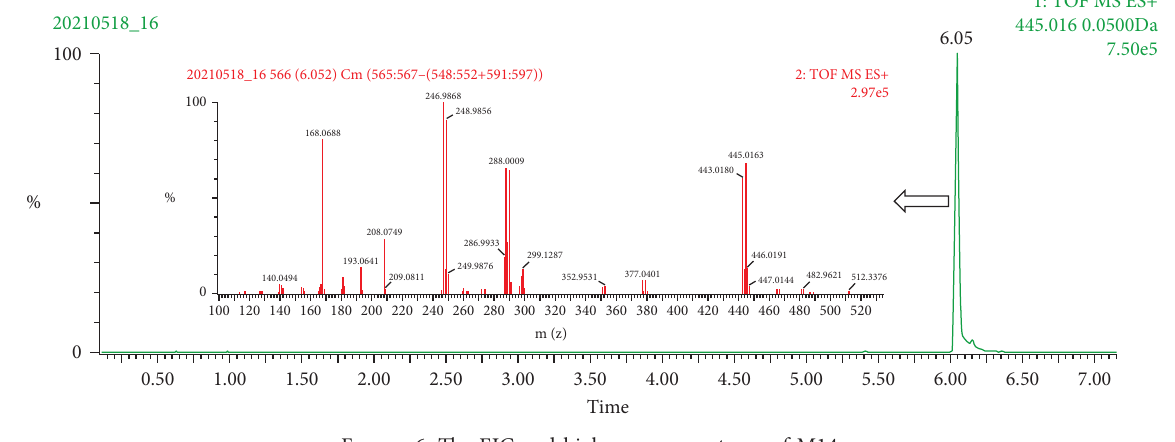
Figure 6: The EIC and high energy spectrum of M14. Table 3: Relative content of 14 metabolites of MC in rat plasma, bile, urine, and feces.